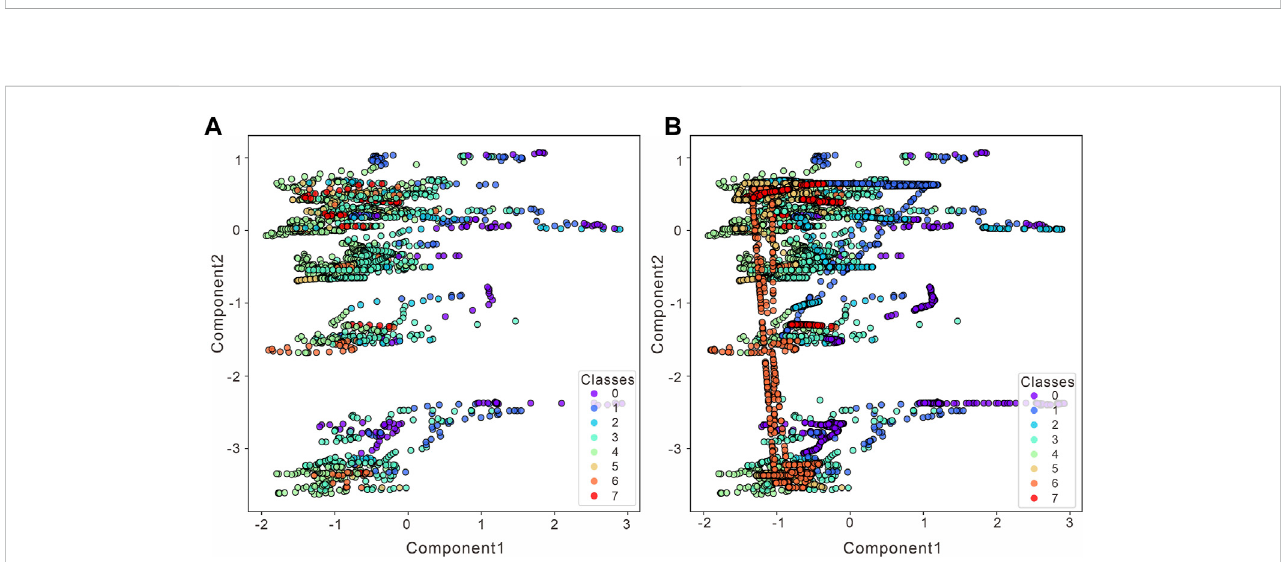
FIGURE 7 ChangesinthelithofaciesdatadistributionbeforeandafterK-meansSMOTE(PCAtransformed). (A) Origindatabeforeresampling. (B) Resampling using K-mean